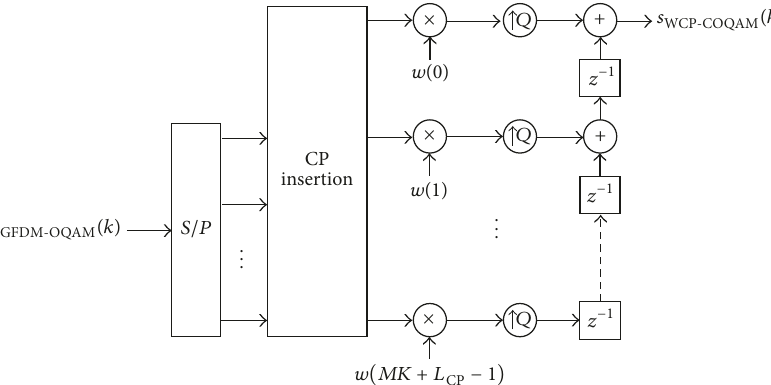
Figure 5: Block diagram of the cyclic prefix insertion and windowing operation for WCP-COQAM. A WCP-COQAM signal is made from a GFDM-OQAM signal and a CP and a window function are applied.